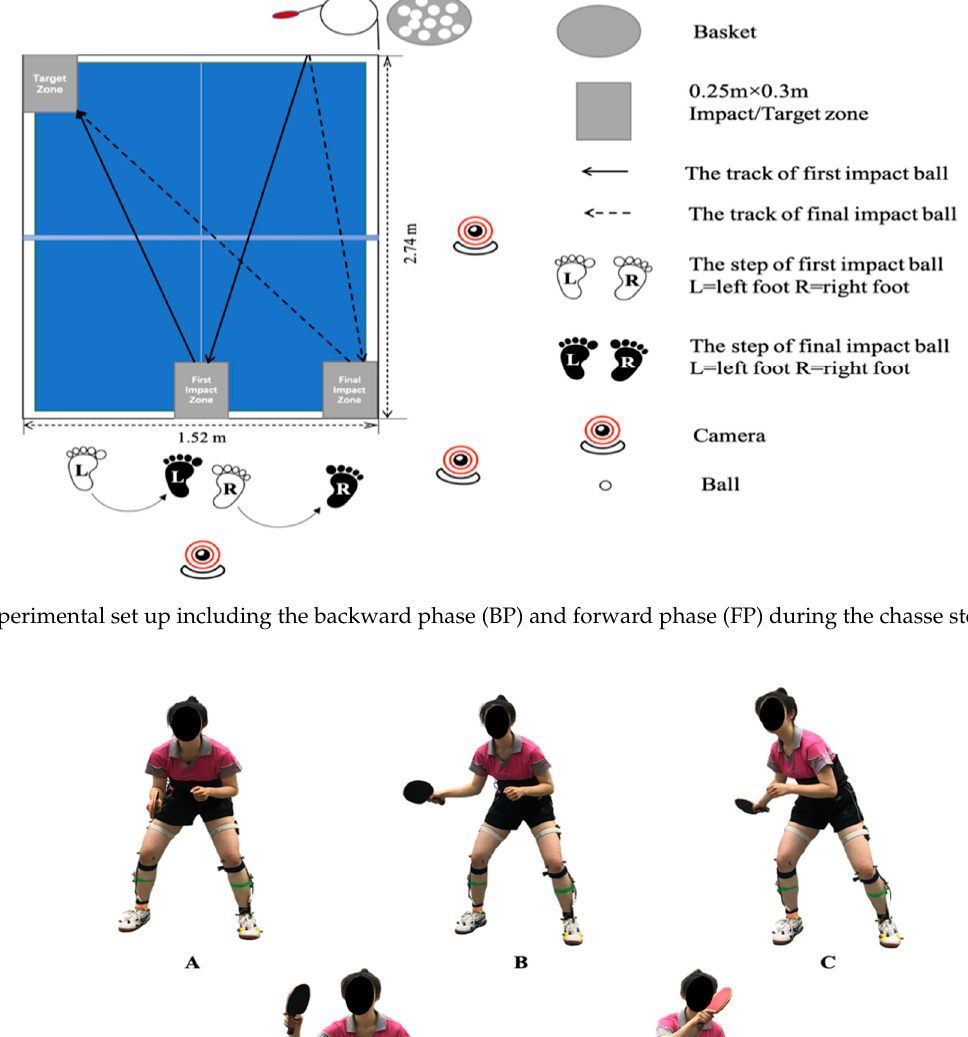
Figure 1. Experimental set up including the backward phase (BP) and forward phase (FP) during the chasse step.